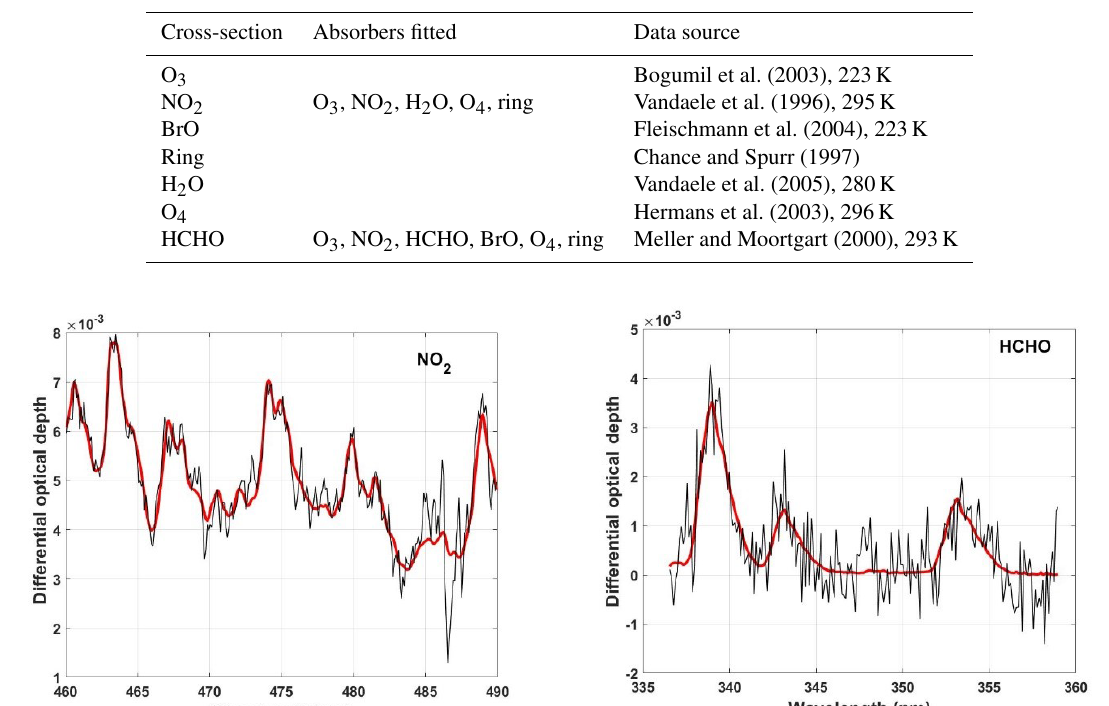
Figure 2. Examples of spectral fitting of NO 2 and HCHO, where red and black lines show the scaled cross-section and the summation of scaled cross-sections and fitting residuals, respectively. The example shows the measurements of 10 April 2017, in Phimai at 10:00LT at an EL of 2 ◦